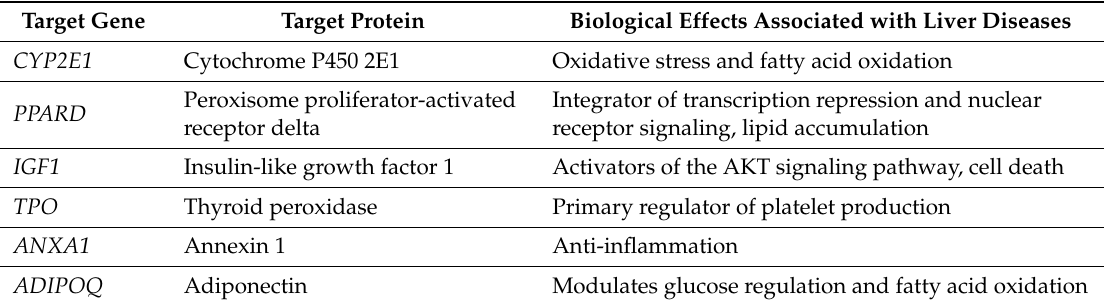
Figure 6. Compound-target network of JGB that is associated with ALD and NAFLD. The red ellipses represent liver disease target genes (26); the blue rectangles (14) are candidate compounds from Danshen; the yellow rectangles (25) are candidate compounds from Wuweizi; the green rectangle (1) is the candidate compound from Yunzhi; the grey lines represent the compound-target interaction. This network comprises 66 nodes (26 target genes and 40 candidate compounds). The compound codes are defined in Table 1. Table 2. The information of major potential targets of JGB in liver